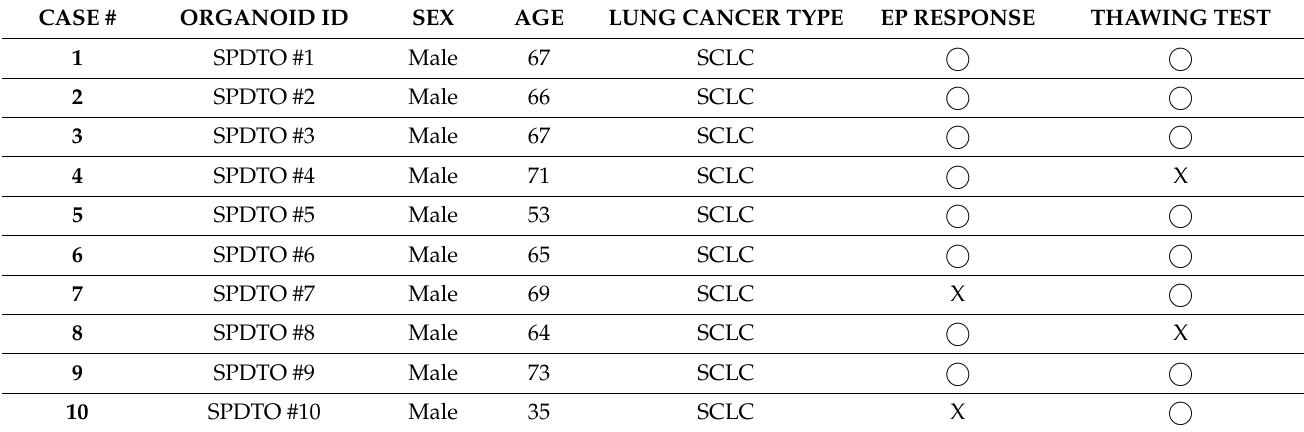
Table 1. The list of small cell lung cancer (SCLC) samples used for the formation of